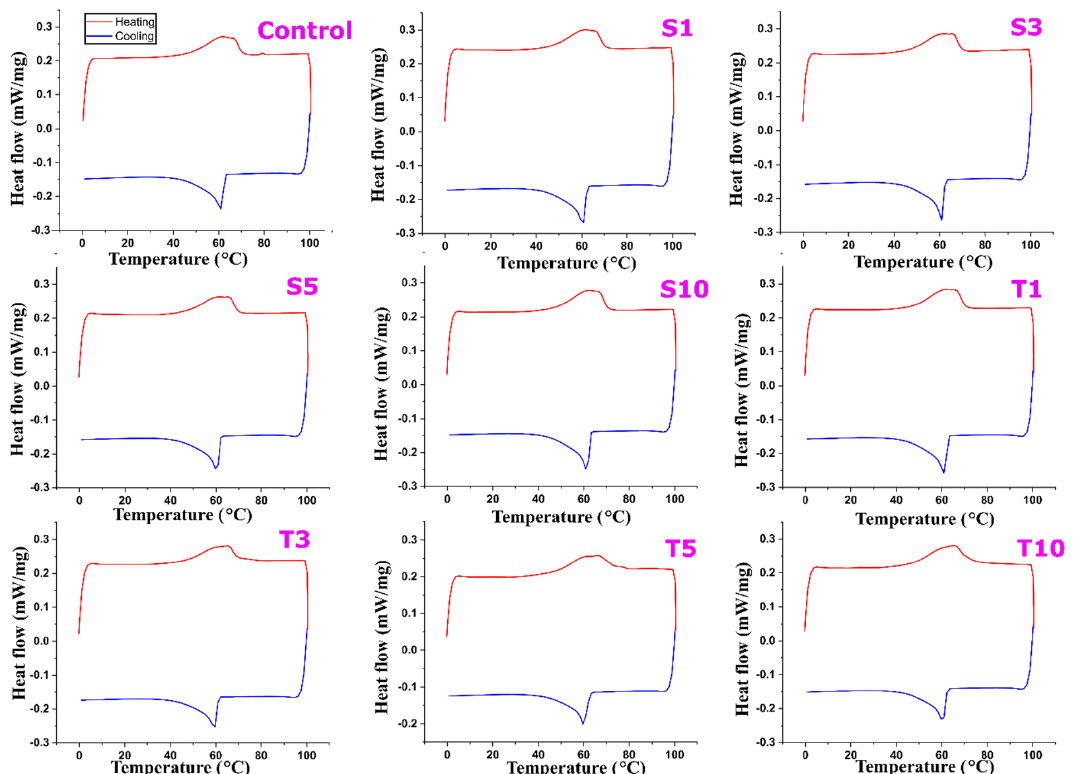
Figure 11. DSC thermograms of formulated oleogels. The details of abbreviations used are provided in Section 4.2 (Table 5).